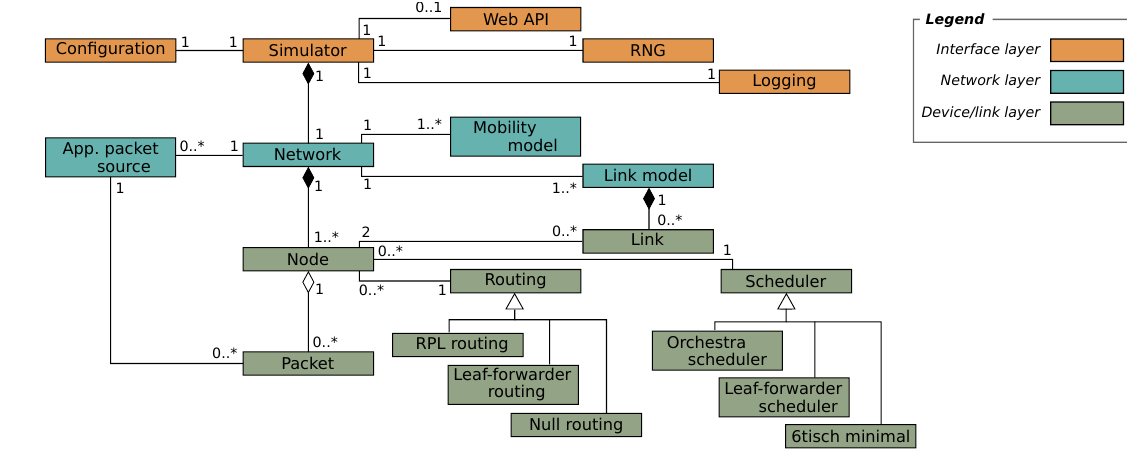
Figure 2. Class diagram of